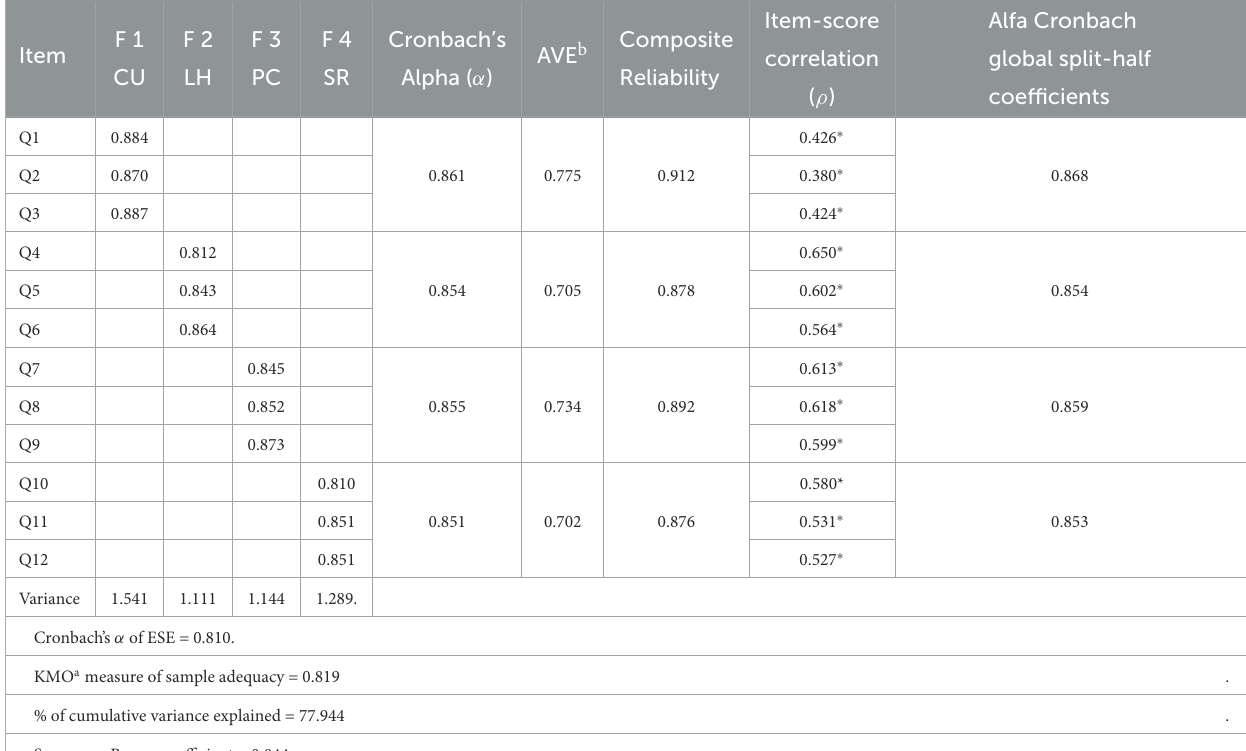
TABLE 3 Results of the exploratory factor analysis (EFA) of group 1.